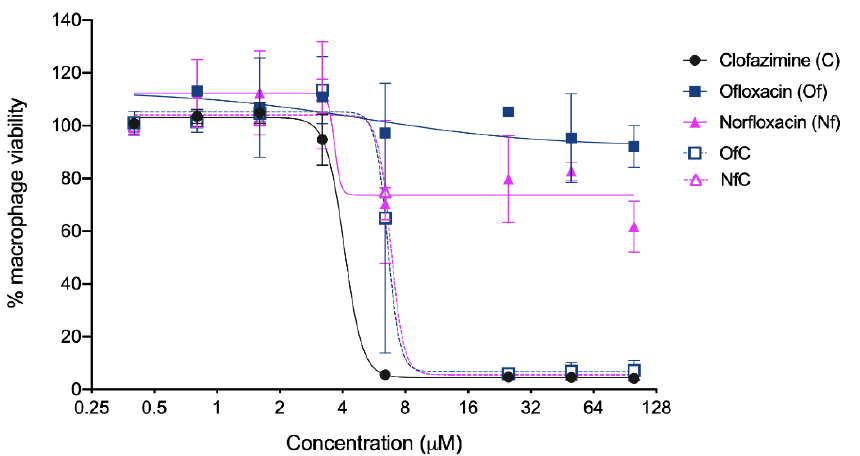
Figure 4. Toxicity of the Clf-derived OSs and their parent drugs to host mammalian cells (murine BMM). The symbols represent the averages ± standard deviations of two to three independent experiments, presented as percentages of viable macrophages relative to non-treated macrophages. The lines represent the non-linear 4PL regression obtained in the GraphPad software for each experimental condition.